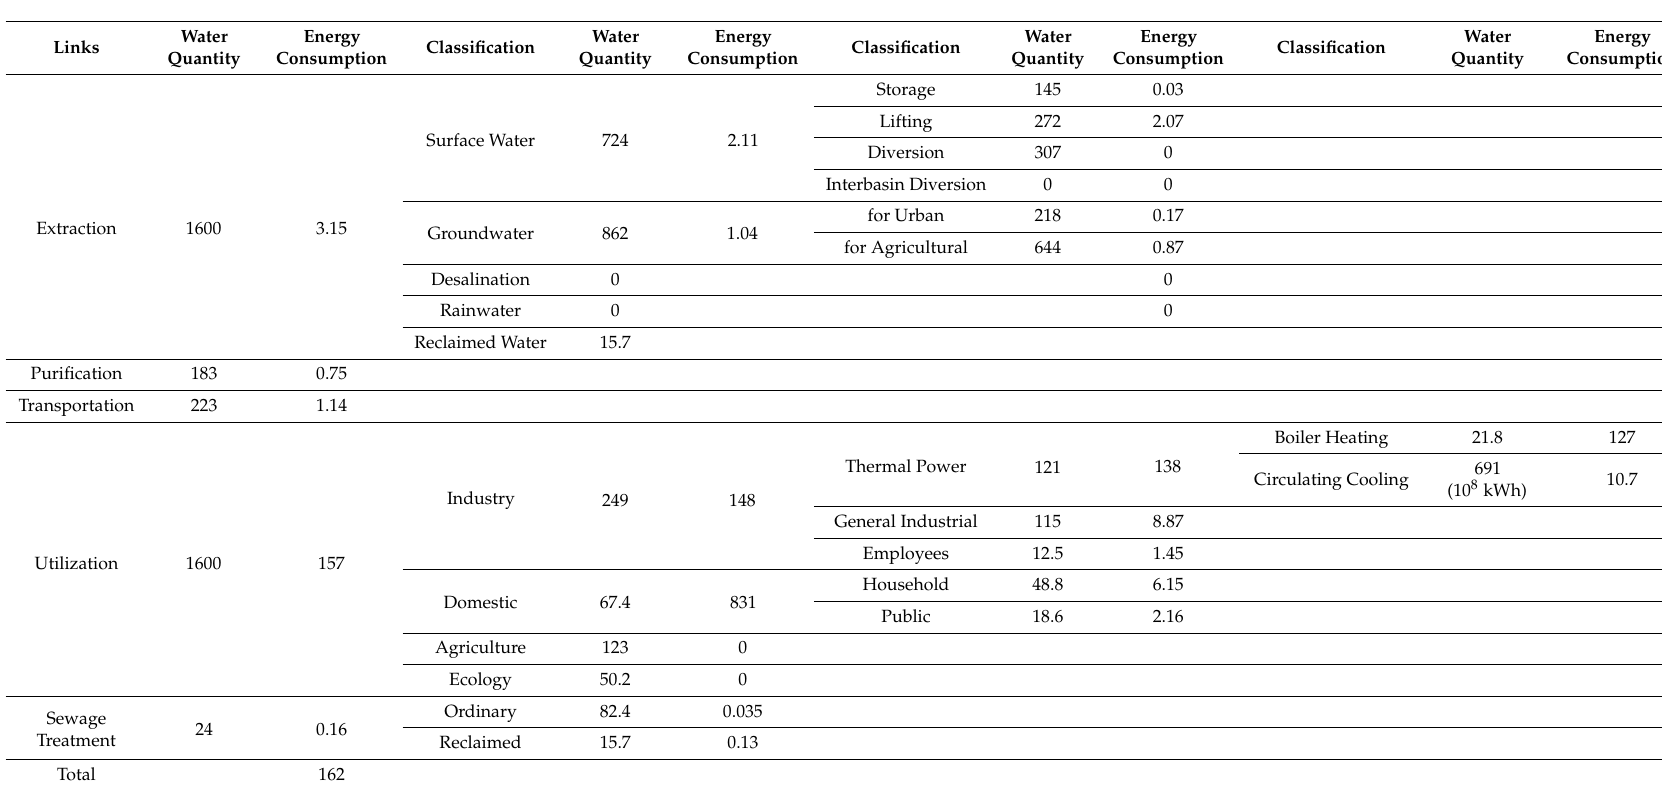
Table A1. Energy consumed through the use of water in Ordos, China, for 2013 (dimension of water quantity: 10 8 m 3 ; dimension of energy consumption: 10 8 kWh; ditto